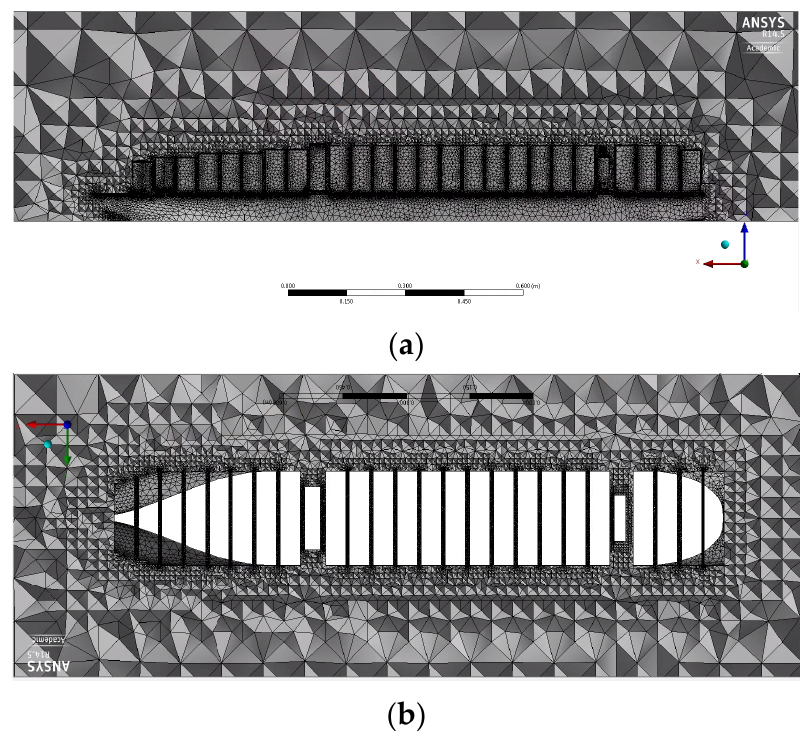
Figure 4. Global mesh. ( a ) Cut mesh at the symmetry plane, ( b ) Cut mesh at the horizontal plane.